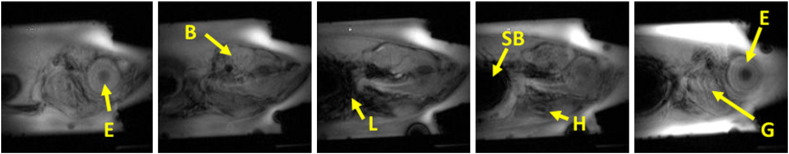
Example in vivo zebrafish MRI images generated using the equipment and protocols outlined in this paper using a Sagittal FLASH-based scan. B = brain, E = eye, G = gill, H = heart, L = liver, M = mouth, SB = swim bladder. Scale bar = 1 mm.